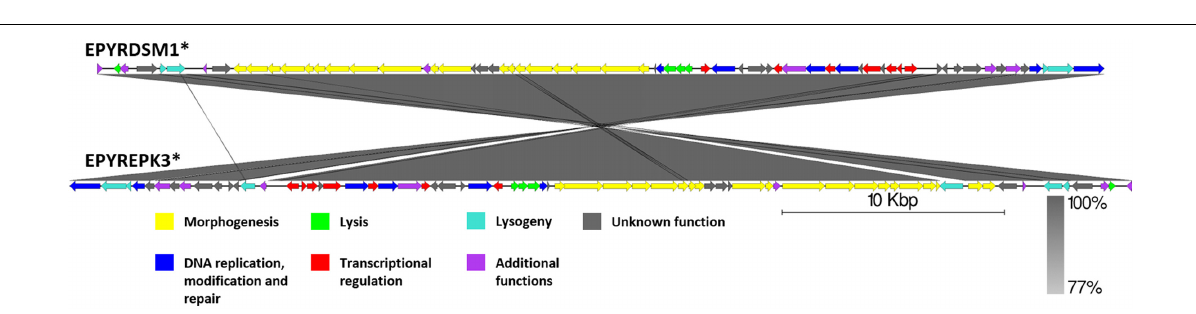
FIGURE 9 | Pairwise genome nucleotide sequence comparison of phages from suggested cluster 5. Genomes are linearized and drawn to scale; scale bar indicates 10 thousand base pairs. Arrows representing open reading frames point in the direction of transcription and are color-coded according to the legend. Gray boxes between genomes represent regions of similarity and are gradient-colored according to their identity; darker shade of gray represents higher identity. Asterisk next to the phage name indicates a prophage derived from chromosome of Erwinia